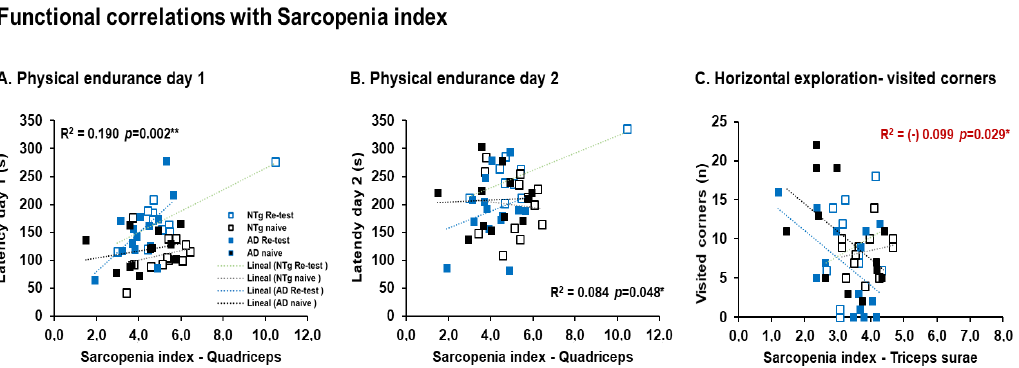
Figure 9. Functional correlations with sarcopenia index. Meaningful, Pearson’s correlations analysis of sarcopenia index. Meaningful, Pearson’s correlation between sarcopenia index quadriceps and